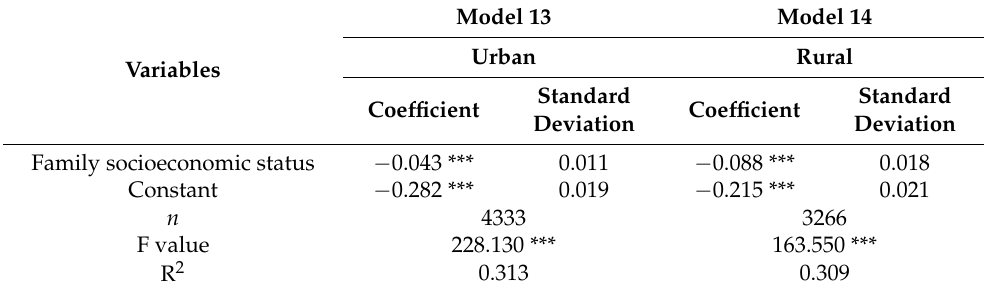
Table 4. Results of multiple linear regression (with explanatory variable) by residential area.